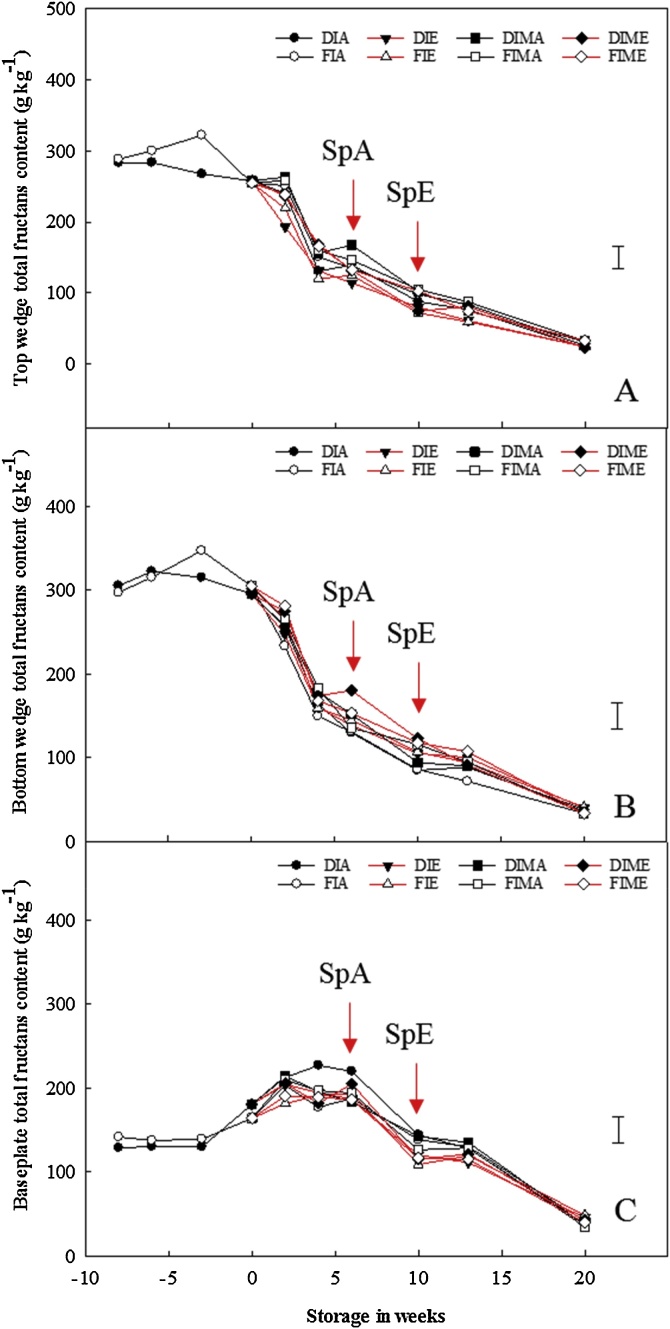
Pre- and postharvest total fructans content in the top wedge, bottom wedge and baseplate of stored onion bulbs treated or untreated with 1-MCP. Total fructans contents (sum of fructans of DP3-8 content) per dry weight for the top wedge (A), bottom wedge (B) and baseplate (C) of onion bulbs of cultivar ‘Sherpa’ grown in 2016 under full irrigation (FI) or deficit irrigation (DI); where FI amounted to 100% replenishment of crop evapotranspiration (ETc) and DI was ETc replenishment at 50%. Bulbs were harvested at full maturity (100% fall-down) and cured under glass for six weeks for both years. Post-curing, bulbs were treated with 1-MCP at 1 μL L−1 for 24 h before storage or untreated with 1-MCP, and were stored at 1 °C under continuous ethylene supplementation at 10 μL L-1 or air. DIMA and FIMA are DI and FI bulbs treated with 1-MCP and stored in air and DIME and FIME are DI and FI bulbs treated with 1-MCP and stored under ethylene. SpA and SpE are sprout emergences for bulbs stored in air and ethylene, respectively. Where pre-harvest = –8; harvest = –6; mid-curing = –3; and end of curing = 0 in weeks. LSD bar at 95% confidence shown.